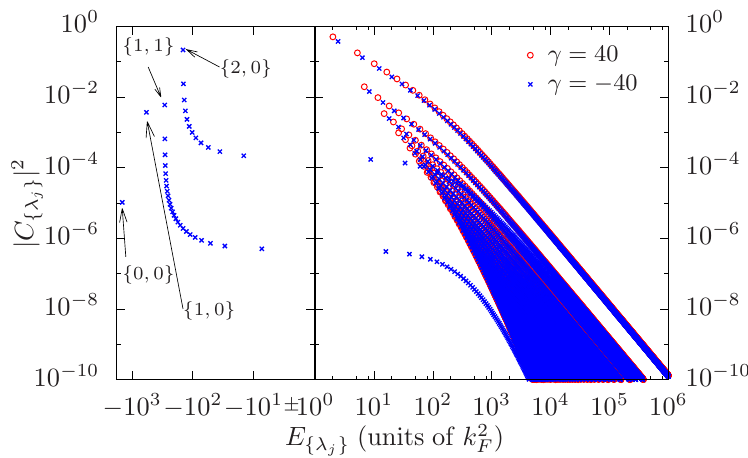
Figure 4: Comparison of populations of eigenstates in the postquench basis for quenches from the ideal-gas ground state to γ = − 40 (blue crosses) and γ = 40 (red circles) for N = 4 par- ticles. To display negative energies on a logarithmic scale, we mirror the energy axis around = 1 k 2 E { λ , plotting the populations of eigenstates with negative energy on the left and those } F j with positive energy on the right. (Note that there are no occupied states with | E { λ Four characteristic bound states with negative energy are labelled with their (ideal-gas) quan- } , and are described further in the main tum numbers { n j